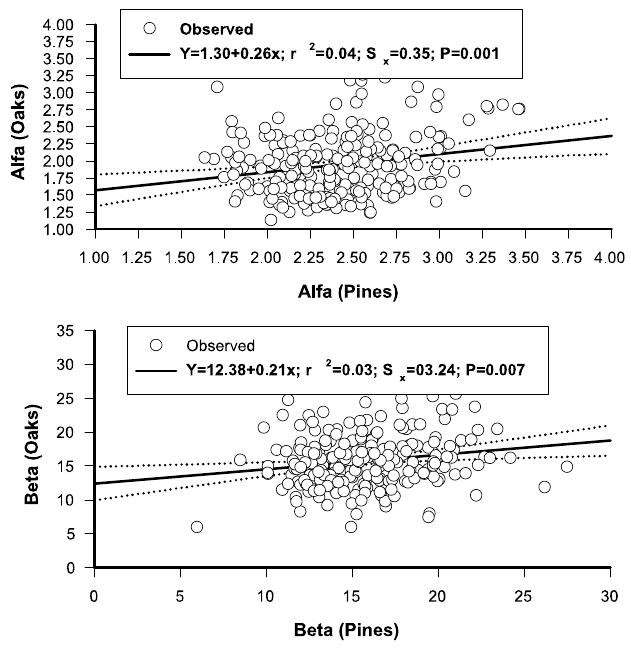
Figure 4. The statistical relationships between the Weibull distribution parameters of oaks and pines ( r 2 = coefficient of determination, Sx = Standard error, P = probability).